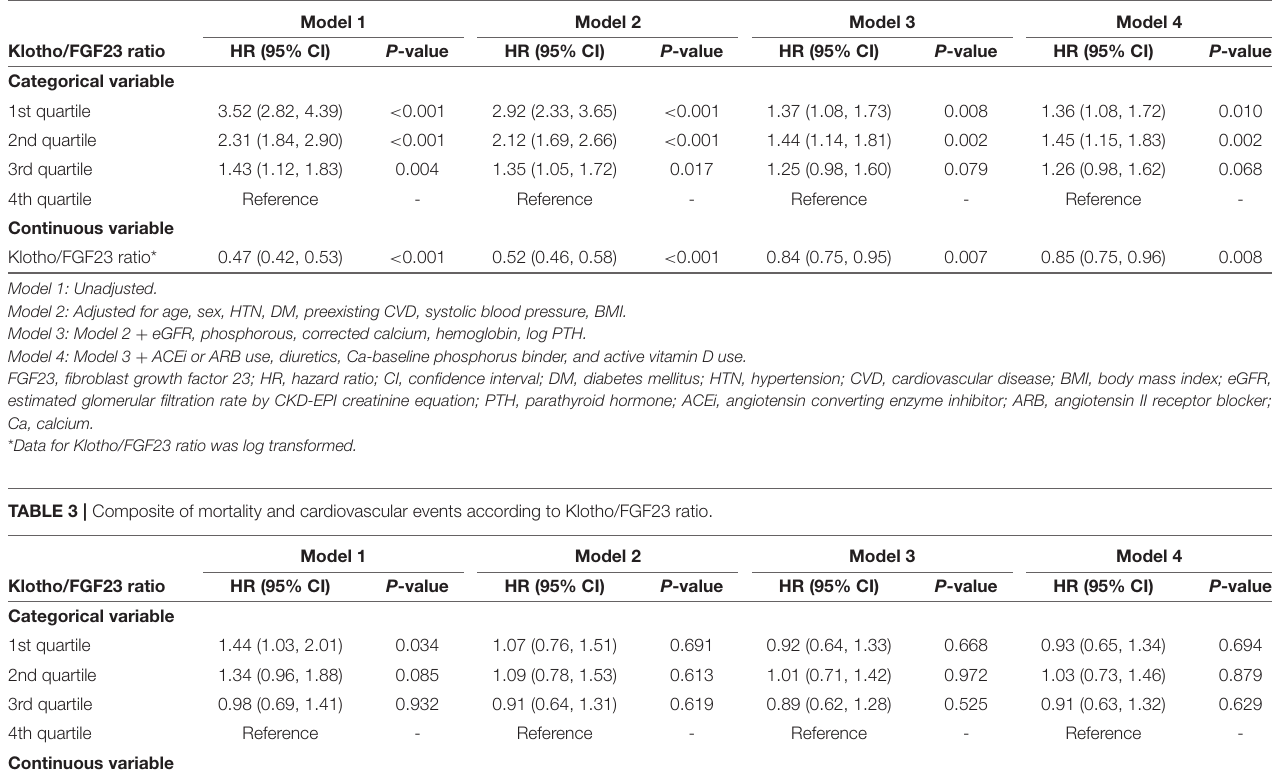
TABLE 2 | Renal events according to Klotho/FGF23 ratio.